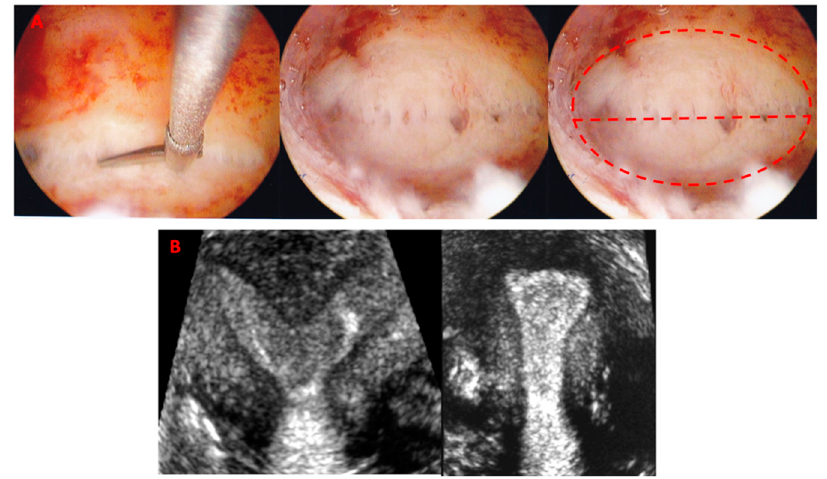
Figure 3. ( A ): surgical incision of a uterine subseptation with cold scissors (left) and resulting uterine cavity (center and right). The tubal ostia are not visualized before and soon after subseptation incision because of the wide cavity. ( B ): a 3-D ultrasound coronal view rendering of a subseptate uterus before and after surgical incision.